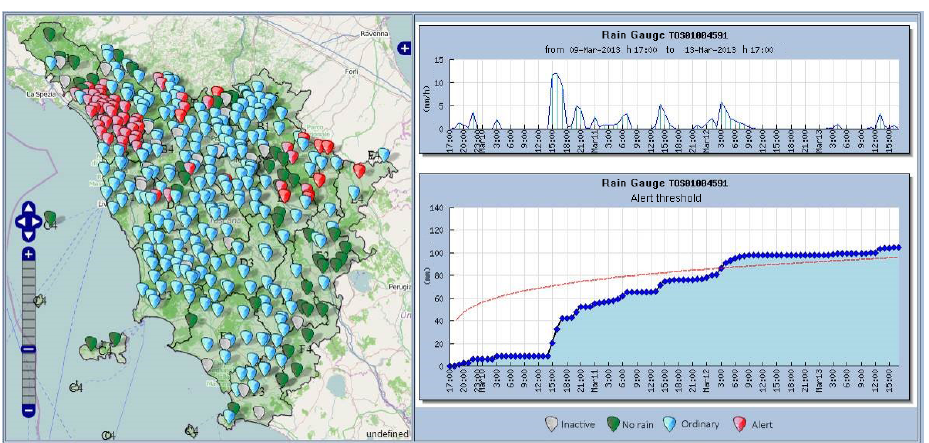
Figure 6. WebGIS interface of the warning system. An overview of the regional rain-gauge network is provided on the left, while on the right, for each rain gauge, the rainfall path can be displayed and compared to the